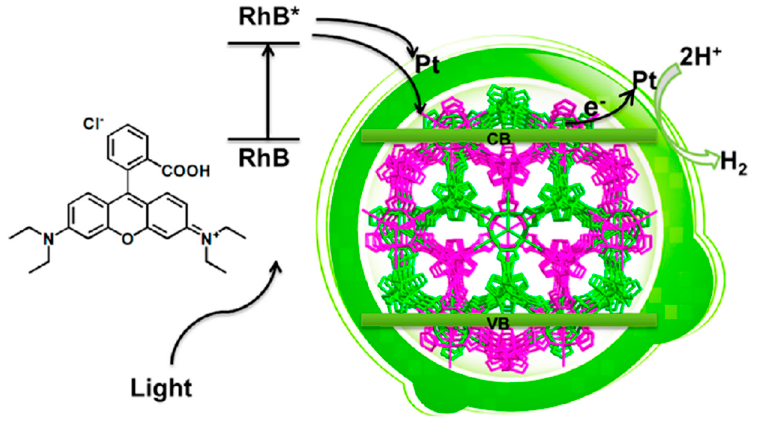
Figure 9. The photocatalytic mechanism of water splitting and hydrogen generation by Co 3 -XL with 2-fold interpenetrated MOFs (Reprinted with permission [127]. Copyright 2021 American Chemical Society).